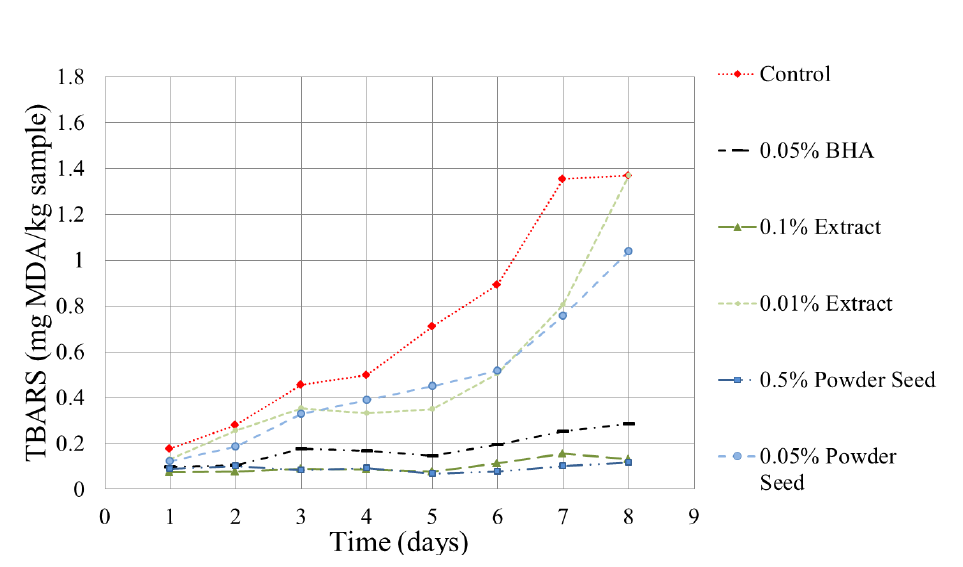
Figure 4. The TBARS (Thiobarbituric acid reactive substances) values for the meat